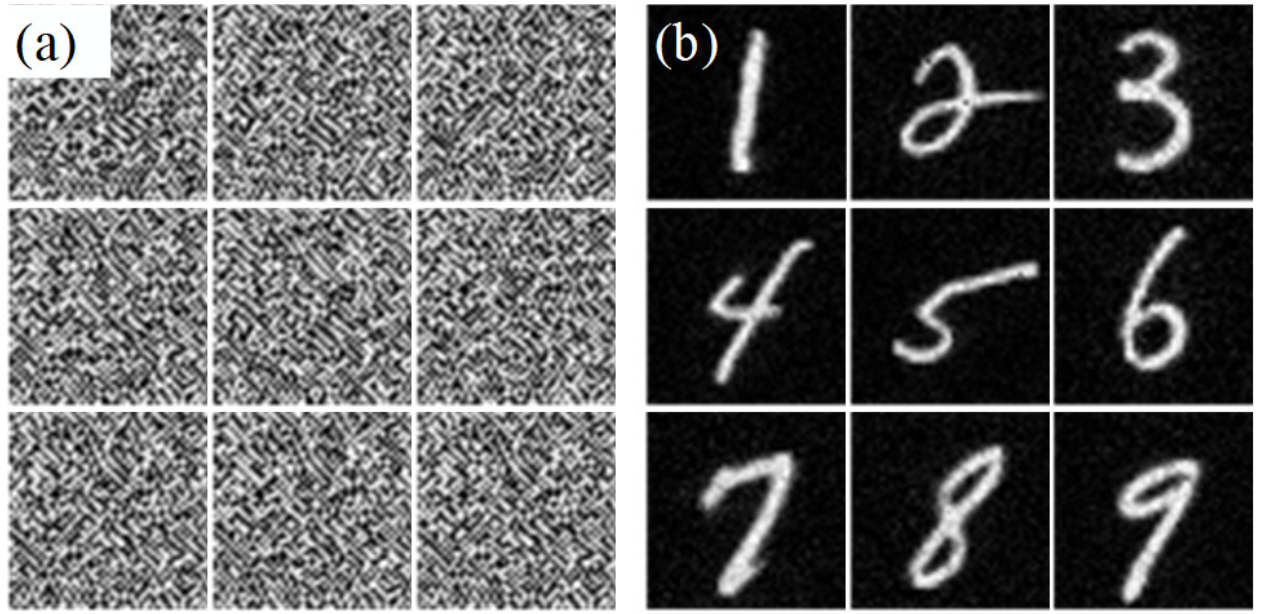
Figure 8. Generated holograms and reproduced images. ( a ) Phase-type hologram generated by MLCNN; ( b ) reconstructed images.